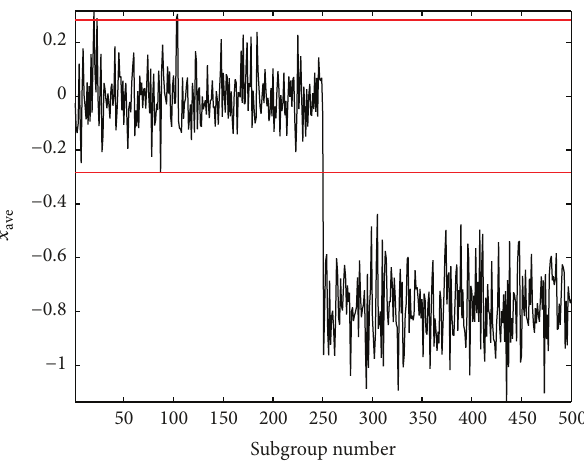
Figure 3: Shewhart control chart for damage detection. Table 1: Parameters of the three linear components (22). Class